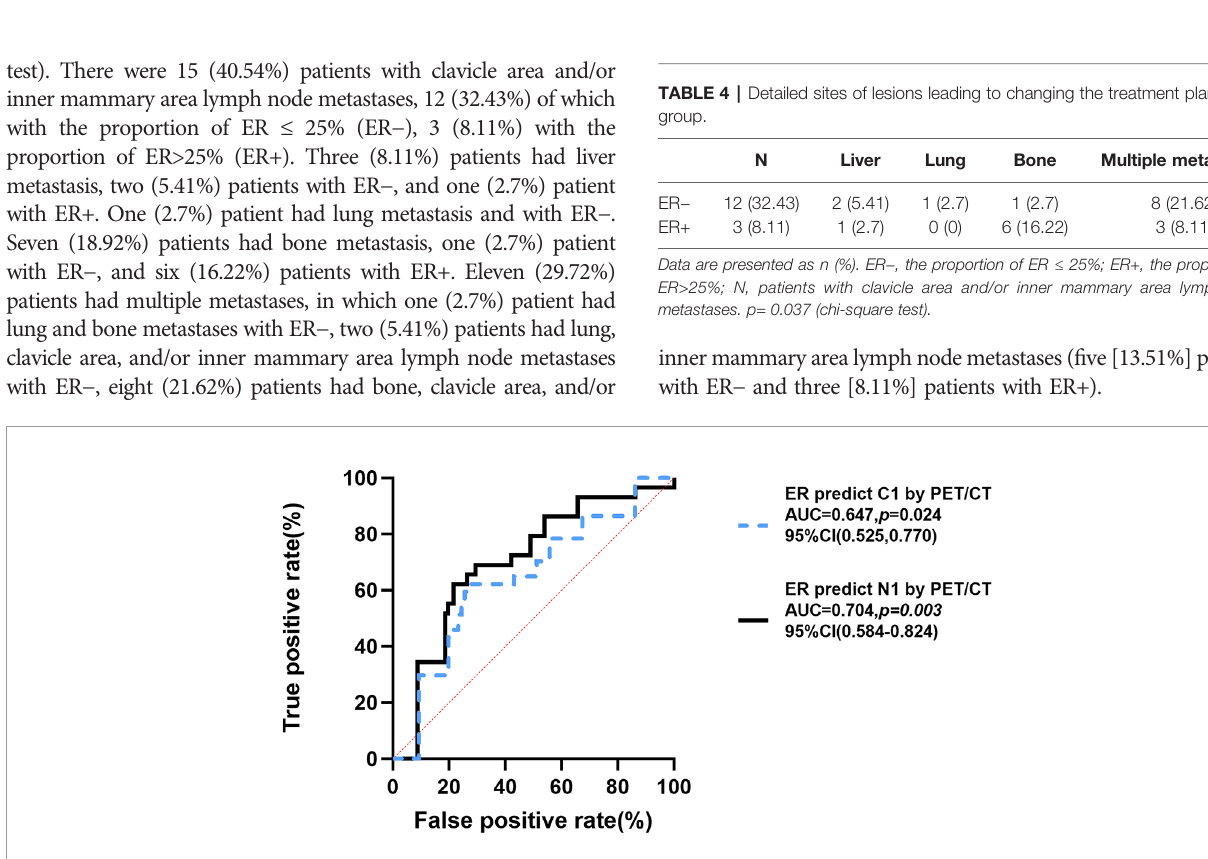
ER, estrogen receptor; PR, progesterone receptor; Time, the time from the discovery of the abnormality (such as lump, pain, and so on) to the fi rst visit to the doctor; Diameter, maximum diameteroftheprimarylesion;Initialstage,stagedbyconventionalimaging(ultrasound,CT,andMR)andclinicalexamination(preliminarybiopsy).P<0.05wasconsideredsigni fi cantand was bolded.